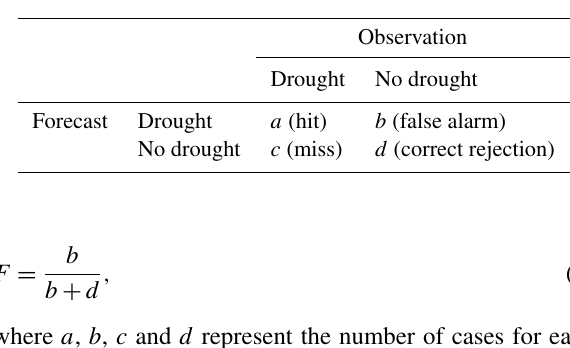
Table 7. Contingency table of the comparison between forecasts and observations.